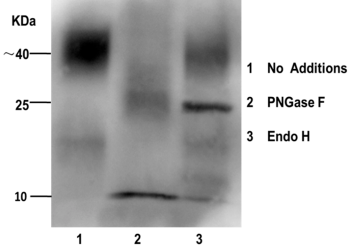
Figure 9. Determination of the N -glycosylation status of PLET1 protein by endoglycosidase treatments and western blotting. Tissue lysates were incubated with PNGaseF or EndoH independently, the extracts were then resolved by SDS-PAGE. Western blotting was probed with anti-porcine PLET1 antibody. Lane 1: Tissue lysates were in absence of PNGaseF or EndoH; Lane 2: Tissue lysates were incubated with PNGase F that removes all N-linked sugars; Lane 3: Tissue lysates were incubated with Endo H, which removes only immature, high mannose-containing, or hybrid sugars.